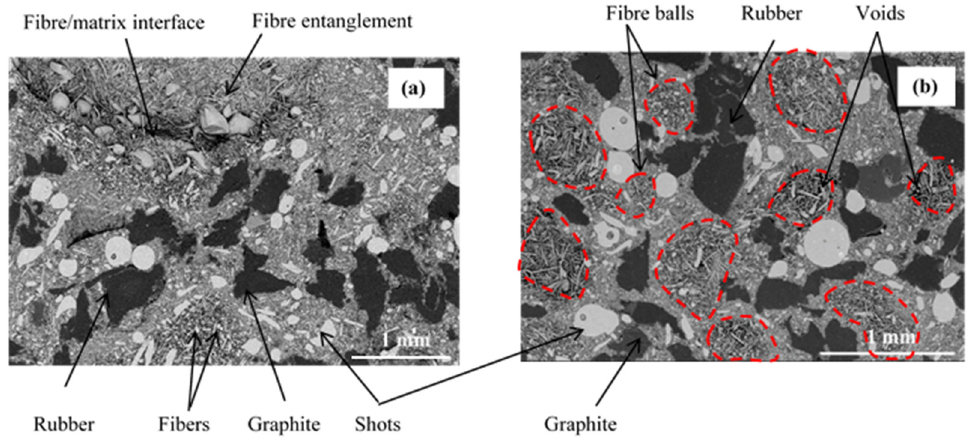
Figure 4. Microstructure of simplified materials ( a ) FMFS and ( b )